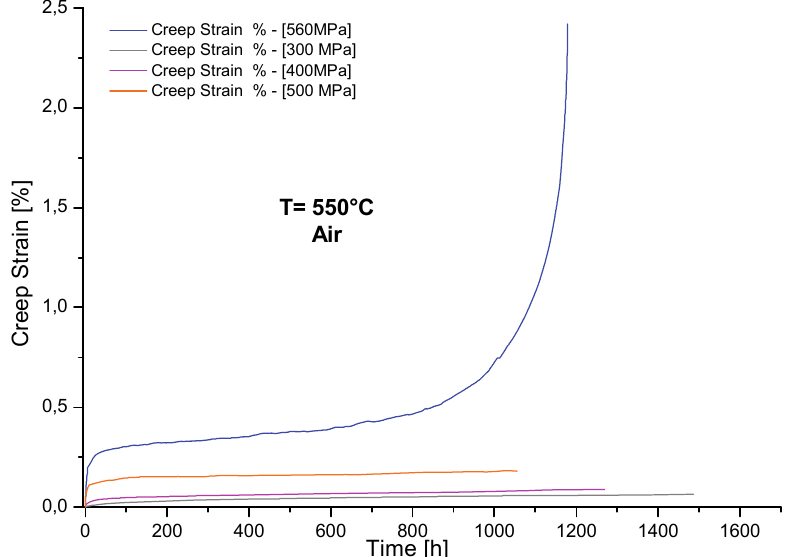
Figure 4: Comparison of 15-15Ti(Si) creep curves in air at 300, 400, 500 and 560 [MPa].